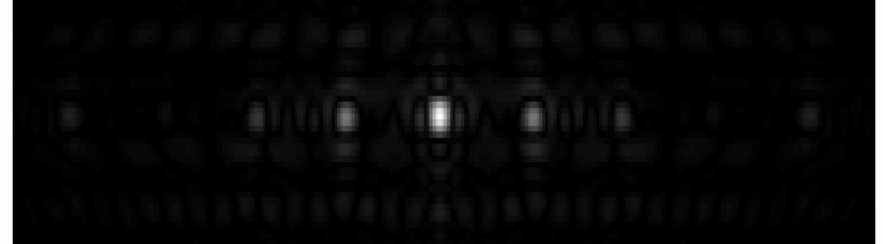
Figure 11. Simulation result of point target of the full-aperture multiple input multiple output- synthetic aperture radar (MIMO-SAR) algorithm.